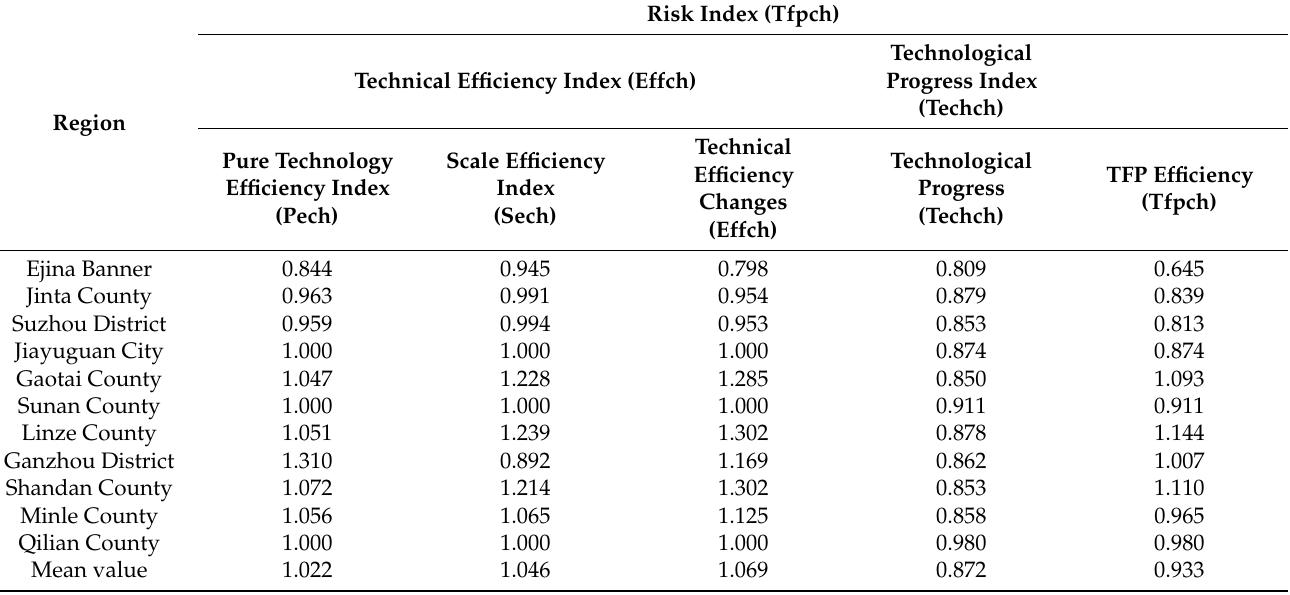
Table 4. Agroecological risk of water index and decomposition by region in the HRB, 1995–2020.